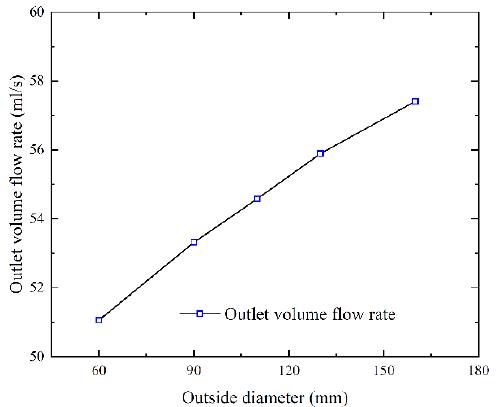
Figure 14. Relationship between the volume flow rate and outside diameter.